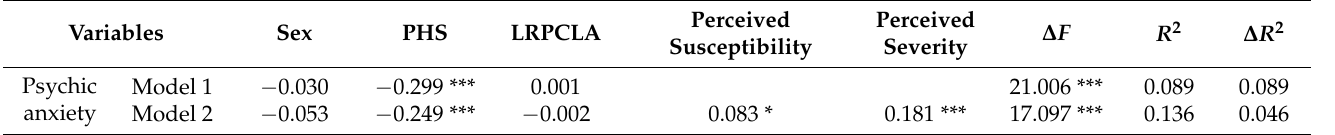
Table 2. Results of the hierarchical regression analysis ( n =